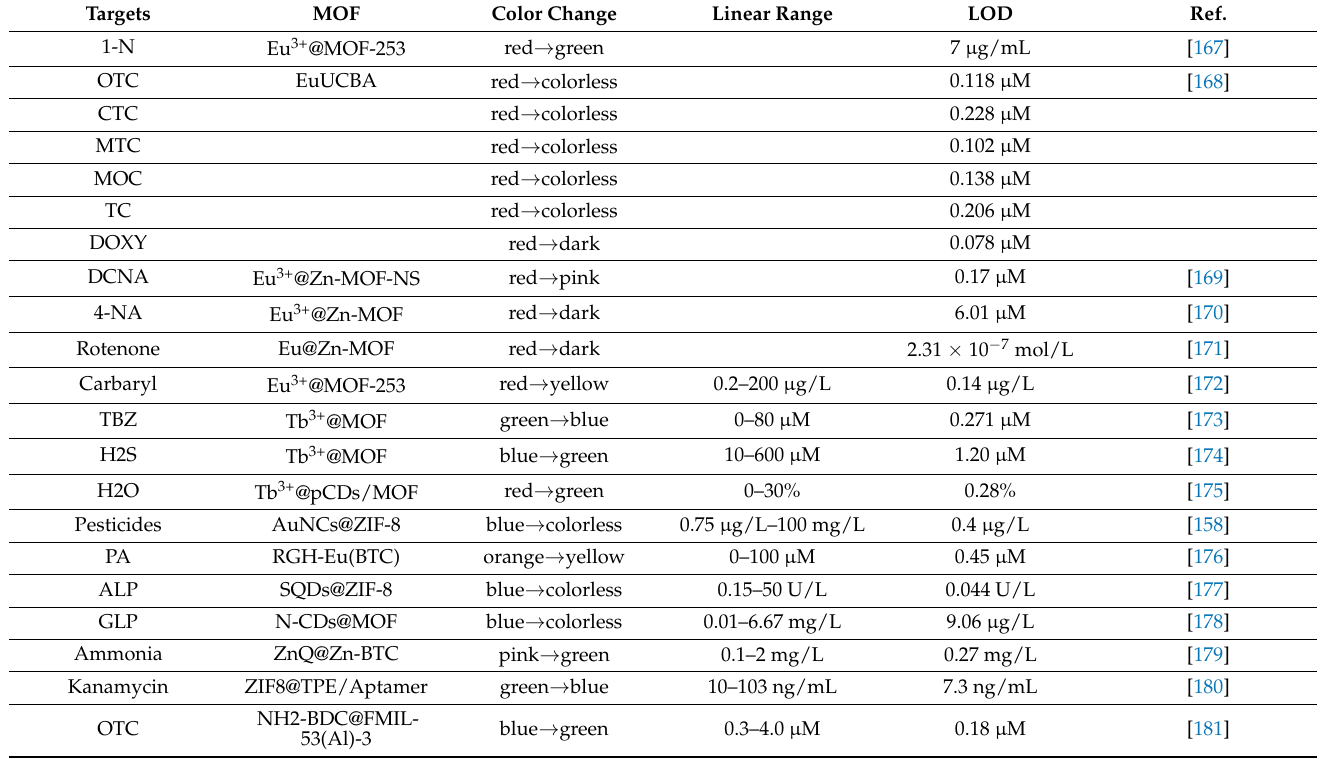
Table 1. Performance of MOF-based fluorescent chemosensors for the detection of small or- ganic